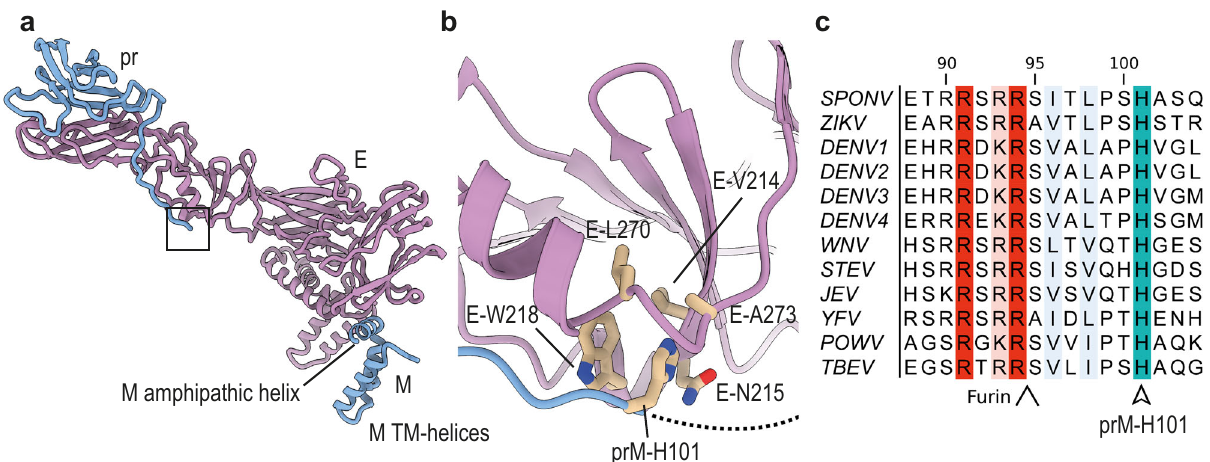
Fig. 2 Anchoring of the prM linker to E. a Zoomed out view of an E-prM complex. The boxed region indicates the location of the prM-H101 pocket. b Zoomed-in view of the boxed region indicated in a . A hydrophobic pocket on the surface of E is shown, into which prM-H101 is inserted. Involved E and prM residues are labeled. c Multiple sequence alignment (MSA) of fl aviviral prM sequences. The positions of the conserved prM-H101 (SPOV numbering) are indicated, as well as the upstream furin site. SPONV Spondweni virus, ZIKV Zika virus, DENV Dengue virus, WNV West Nile virus, SLEV Saint Louis encephalitis virus, JEV Japanese encephalitis virus, YFV Yellow Fever virus, POWV Powassan virus, TBEV Tick-borne encephalitis